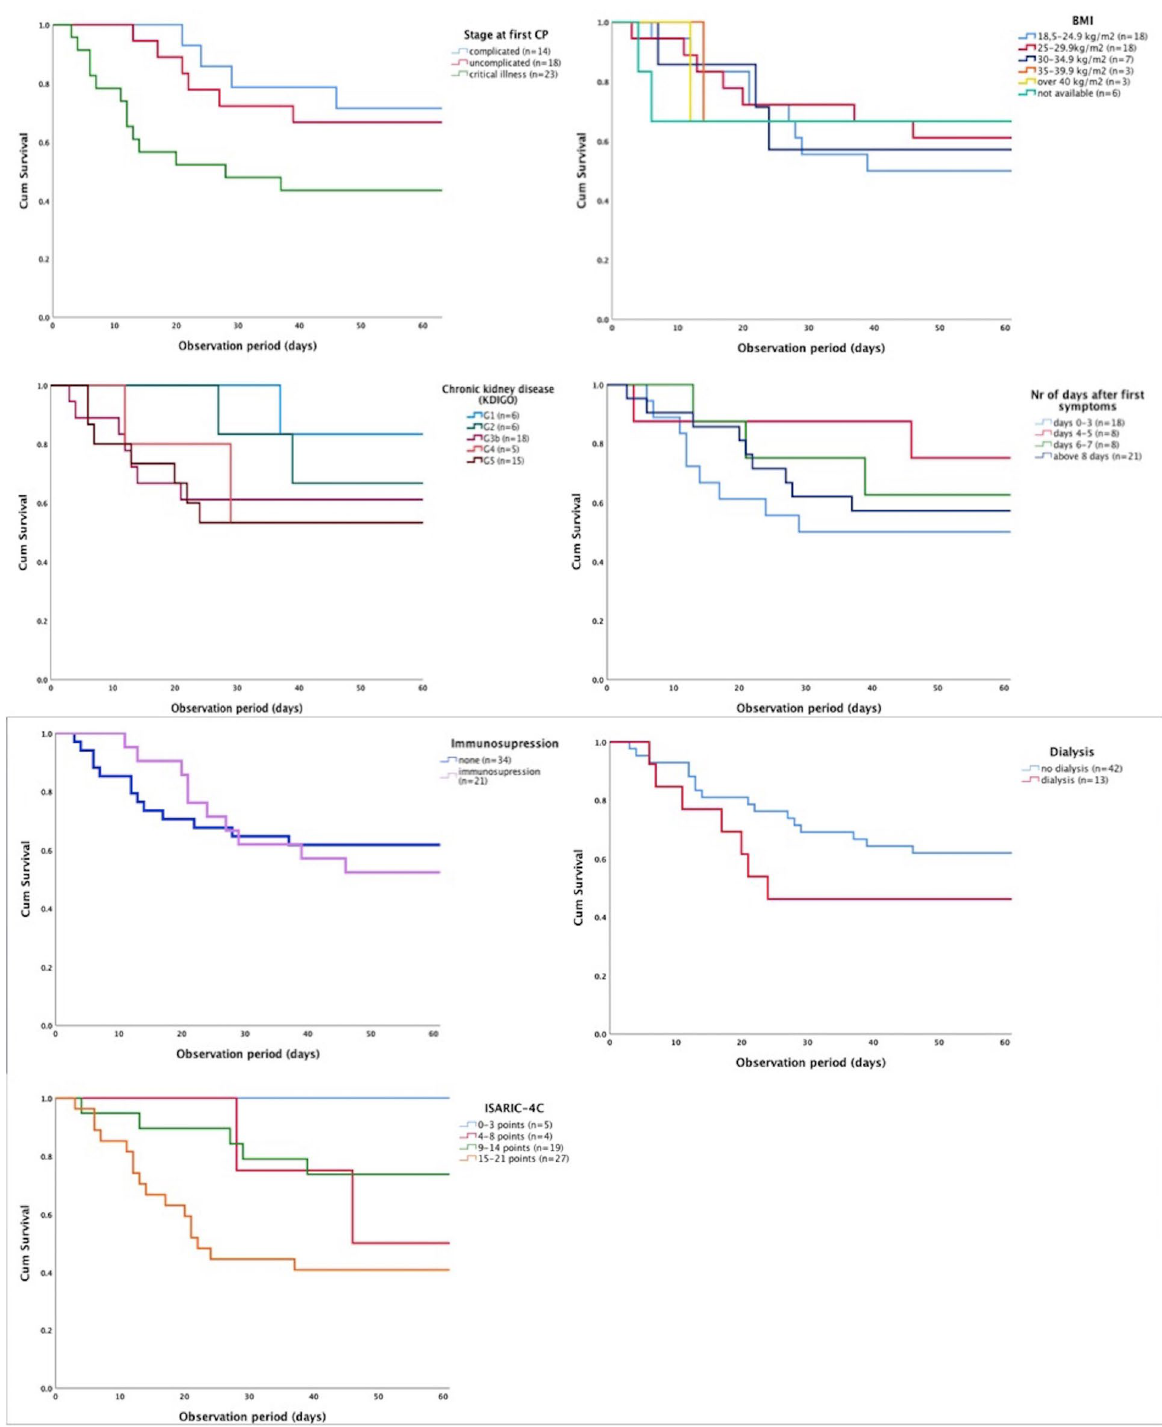
Figure 1. Kaplan–Meier survival plots for various parameters. CP convalescent plasma, BMI body mass index, KDIGO Kidney Disease Improving Global Outcomes, ISARIC-4C Coronavirus Clinical Characterisation phase ranged from 0.3 to 40.1%. Out of the five patients with ISARIC-4C score under 3, only two patients did not have other risk factors such as reduced kidney function, immunodeficiency or advanced age. There were only ten patients who did not have lung infiltrates at administration of first CP/CPs. The mortality rate in this small subgroup was 10% (1/10).